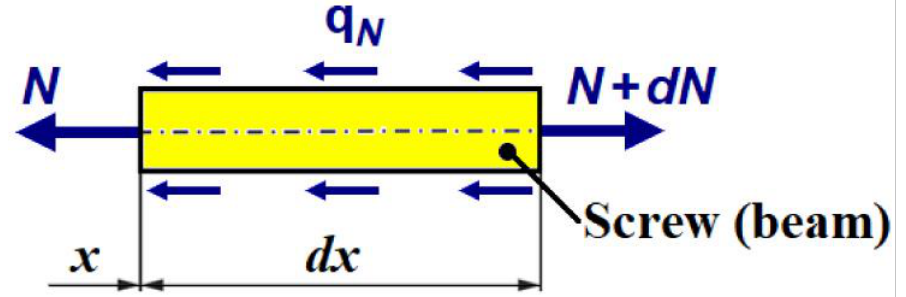
Figure 3. Section of the beam (screw) resting on a tangential elastic foundation, where N [N] is a normal (axial, internal)